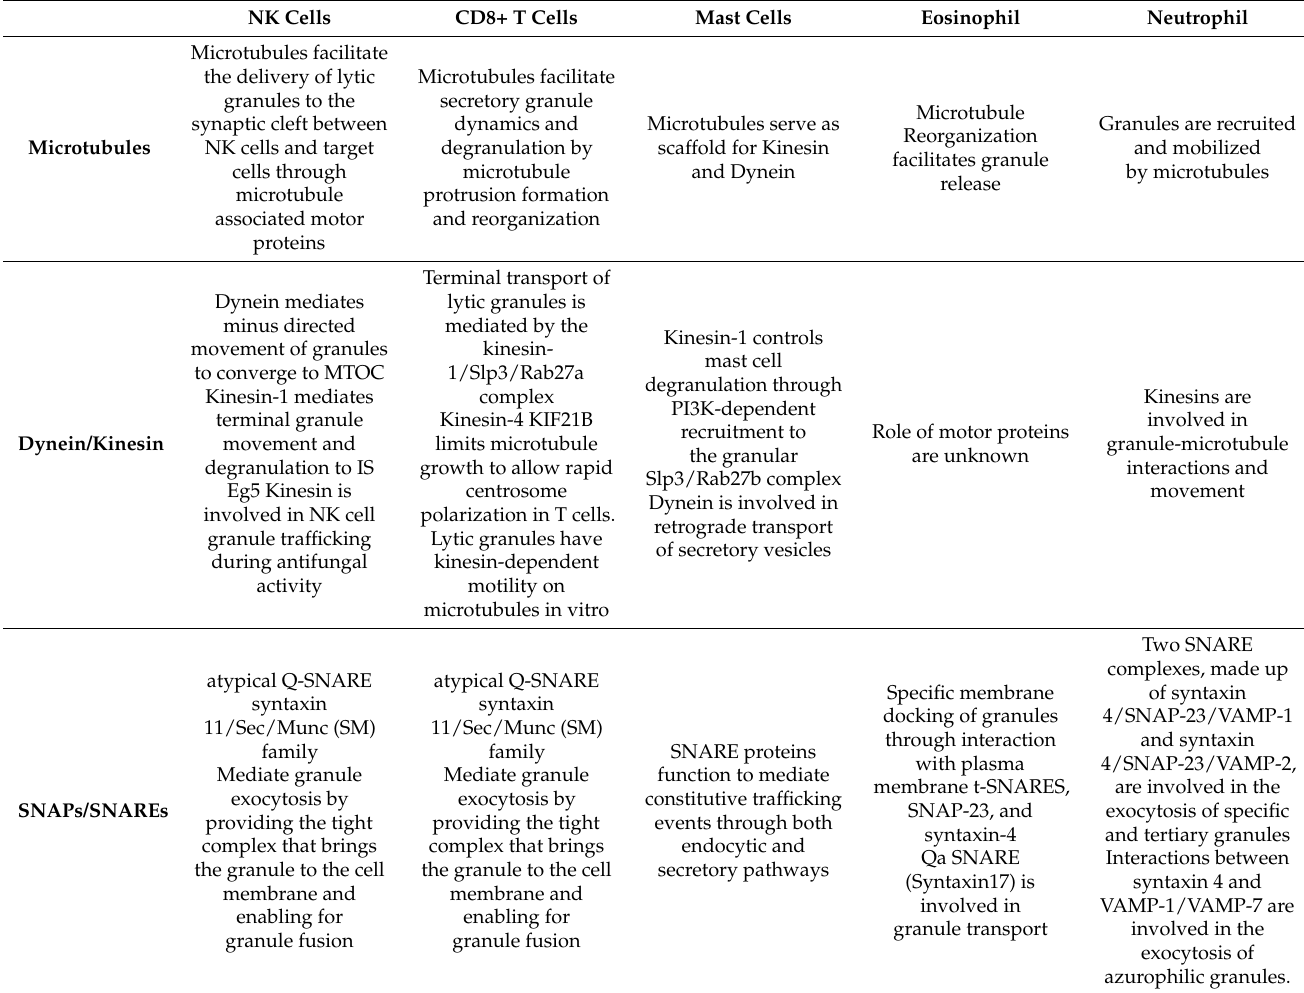
Table 3. The roles of microtubules, dyneins, kinesins, and SNAPs/SNAREs in granule trafficking in various immune cells.